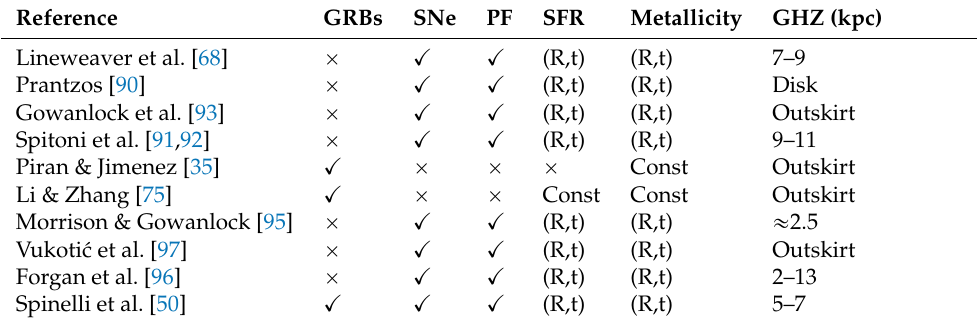
Table 1. Summary of the most relevant literature dealing with the definition of the GHZ. The different effects of life-threatening events (GRBs and SNe) and the probability of forming terrestrial planets are accounted for ( (cid:88) ) or not ( ˆ ) as marked. The assumptions for the spatial and temporal evolution of the star formation rate (SFR) and metallicity are also reported (ignored ˆ , assumed constant, or evolving with galacto-centric distance R and cosmic time